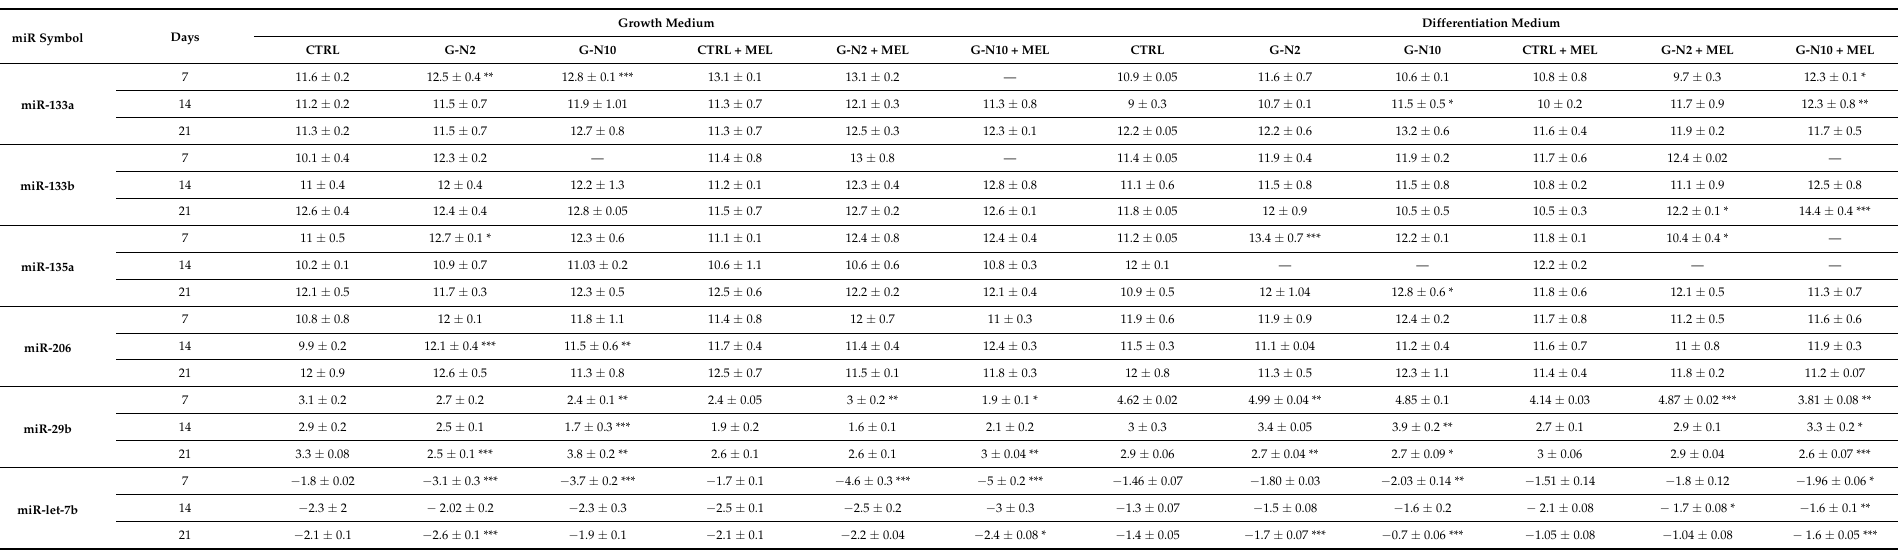
Table 2. miRNA expression